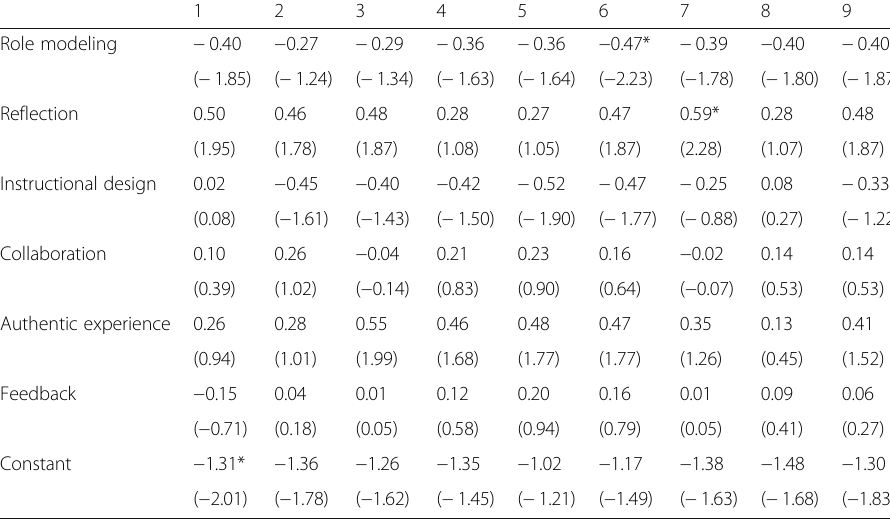
Table 5 Effect Sizes of SQD-training Strategies on